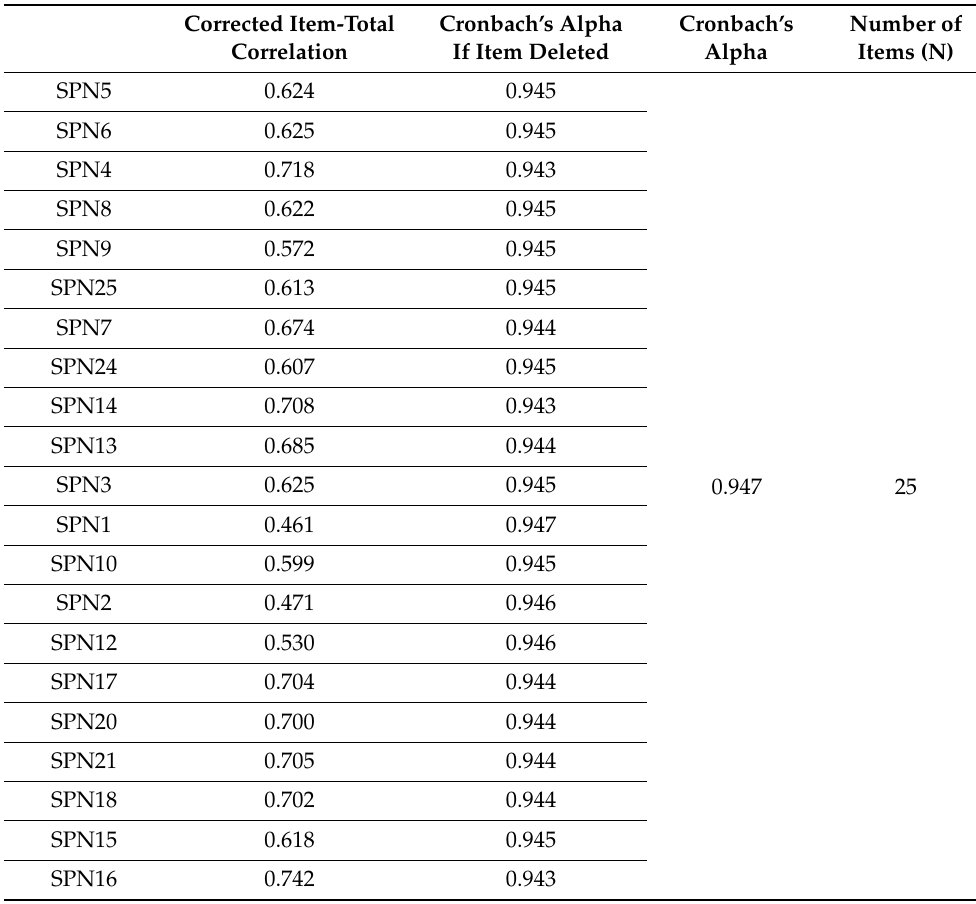
Table 6. Cronbach’s